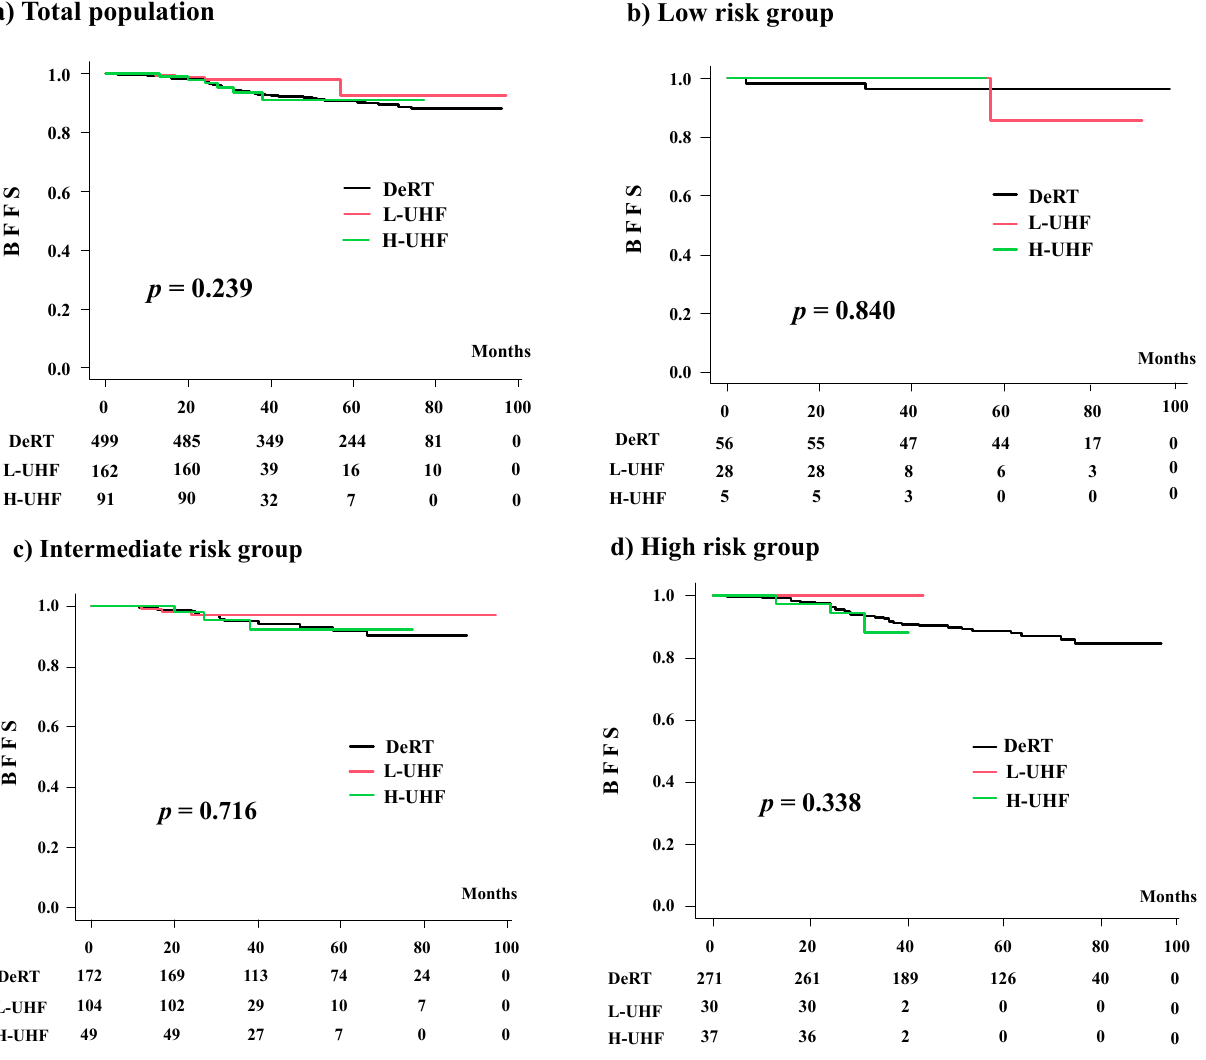
Figure 4. Biochemical control rates (BFFS) among three groups (L-UHF vs. H-UHF vs. DeRT).